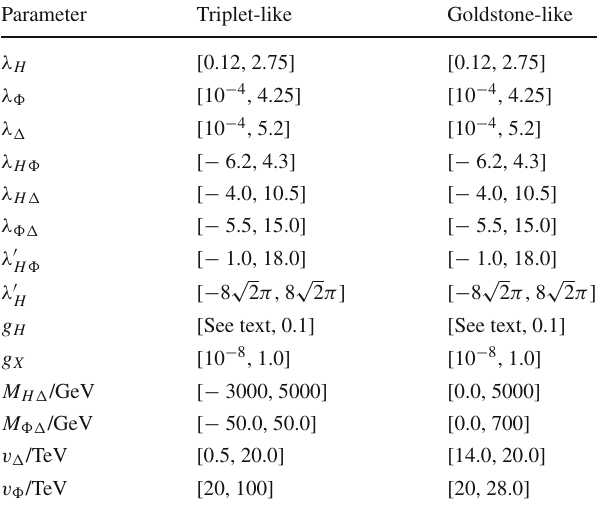
Table 3 Parameter ranges used in the numerical scans that pass SGSC constraints. Here, M X is fixed at 2 TeV and M Y = 0 Parameter Triplet-like